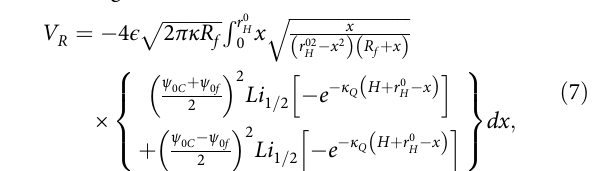
calculated using 50